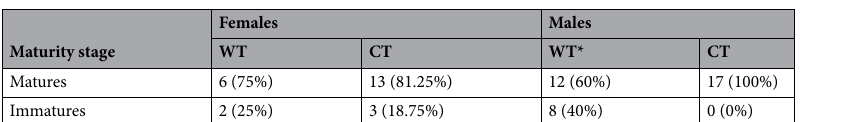
Table 1. Number of mature and immature adult fish at both control (CT) and warm temperature groups 16 mo after treatment. Number in parentheses represent the frequency of animals in each group. *Represent significant difference for Fisher ʼ s test considering p <